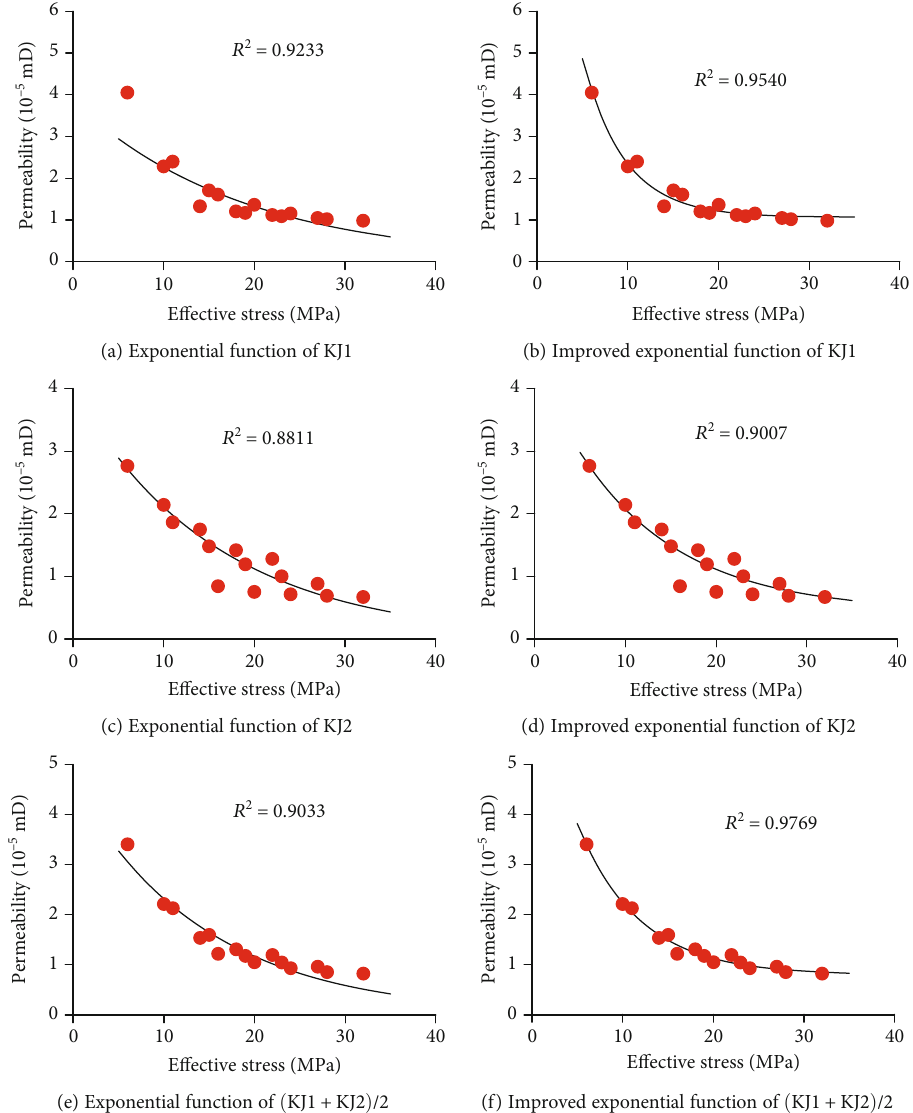
Figure 8: Fitting results of permeability with e ff ective